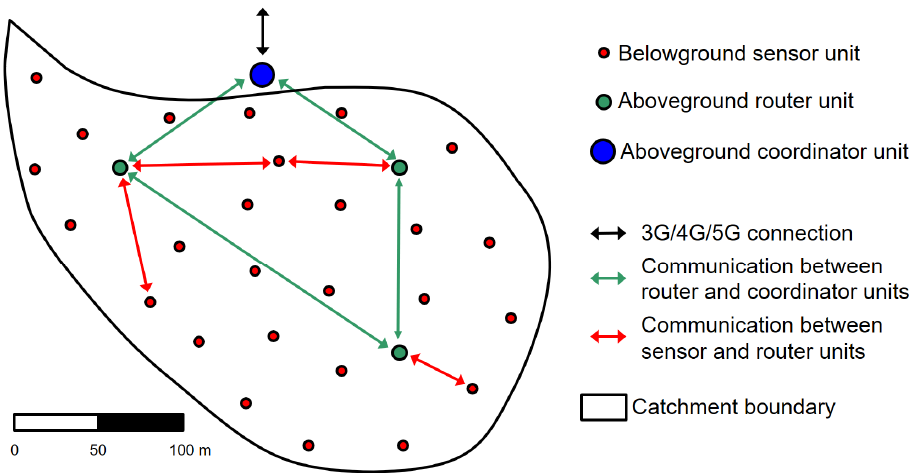
Figure 3. The hybrid wireless underground network topology of SoilNet exemplified for a virtual catchment area (adapted from Bogena et al. [14]).